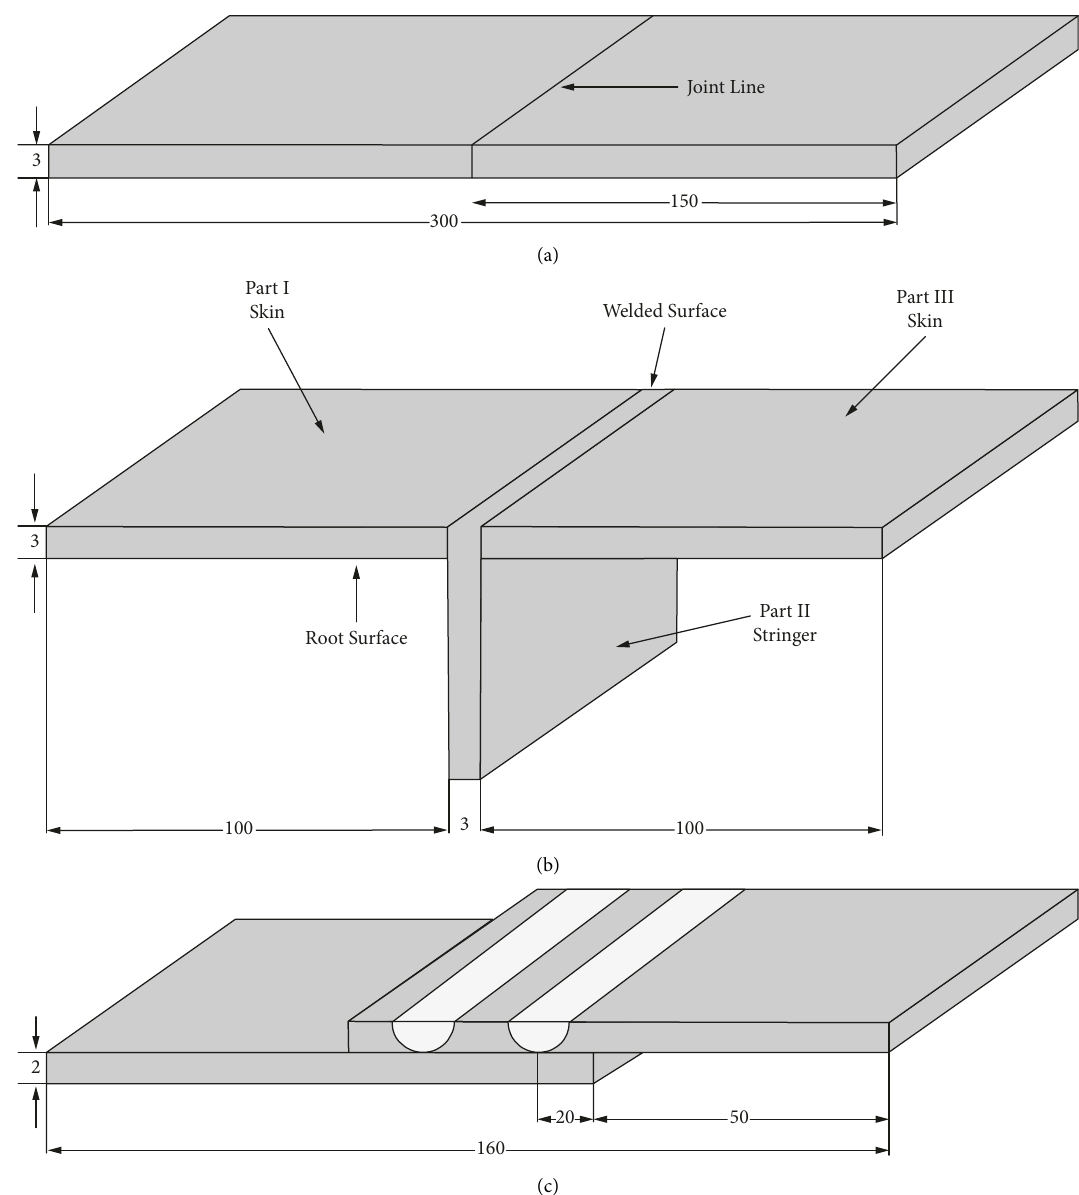
Figure 2: Joint configurations of (a) butt joint, (b) T joints, and (c) lap joints are